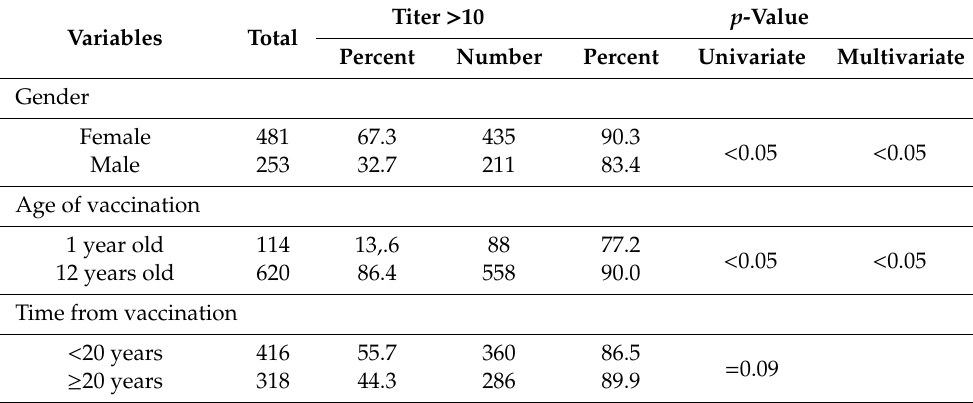
Table2. Associationbetweengender, ageofbirth, timefromvaccinationandprotection(titer > 10UI / mL). Univariate and multivariate analysis.